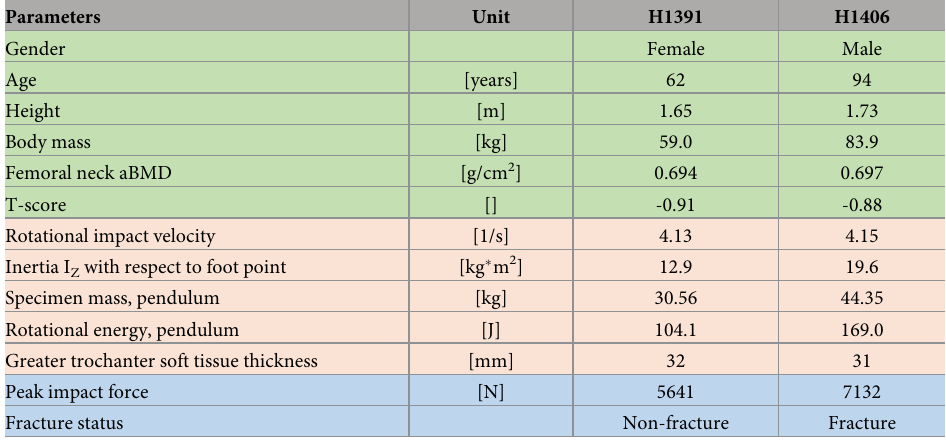
Table 1. Specimen information. Donor data is shaded in green, experimental impact parameters are shaded in orange and experimental results are shaded in blue. (a more detailed table can be found in S1 Detailed specimen